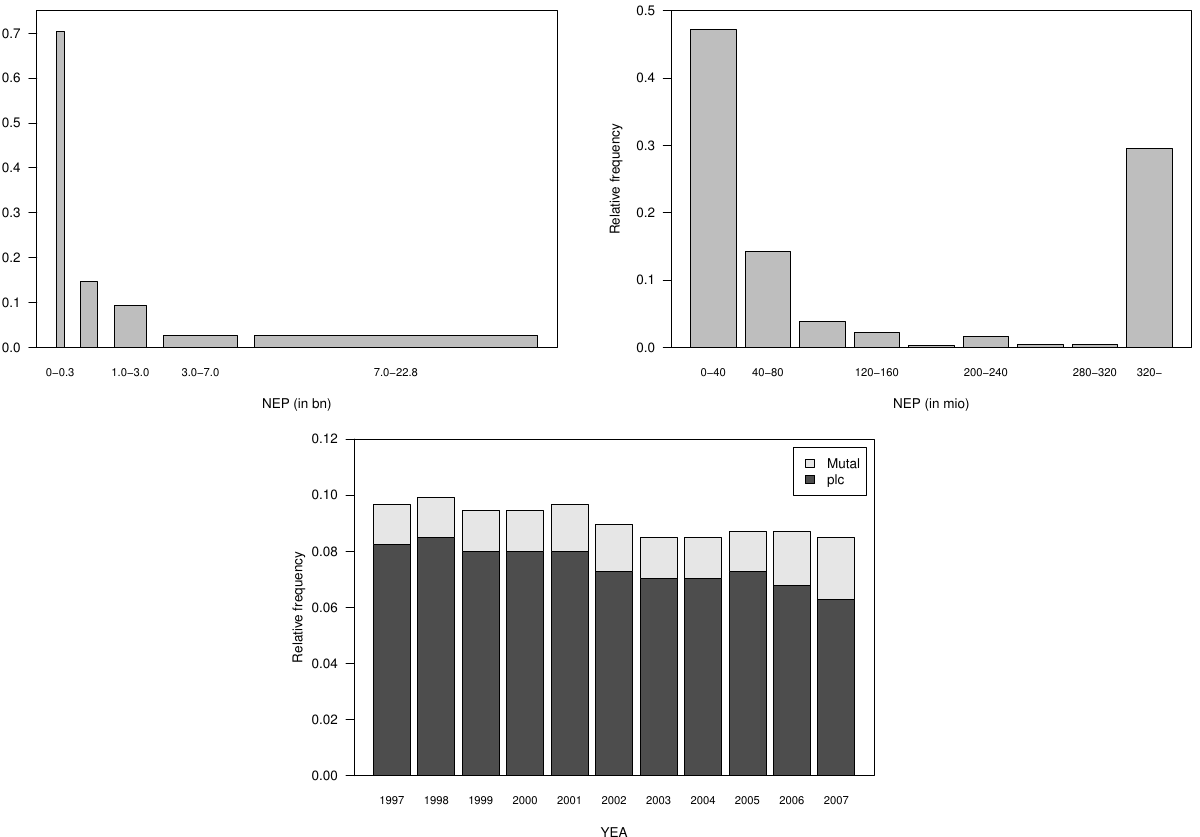
Figure A7. Relative frequency of the net earned premium ( NEP ) and of the calendar year ( YEA ) for non-life undertakings. The figure presents twice the relative frequency of the NEP : once sliced by the optimal bin out of our model and once sliced by equal bands, whereby the last band includes all remaining higher observations.